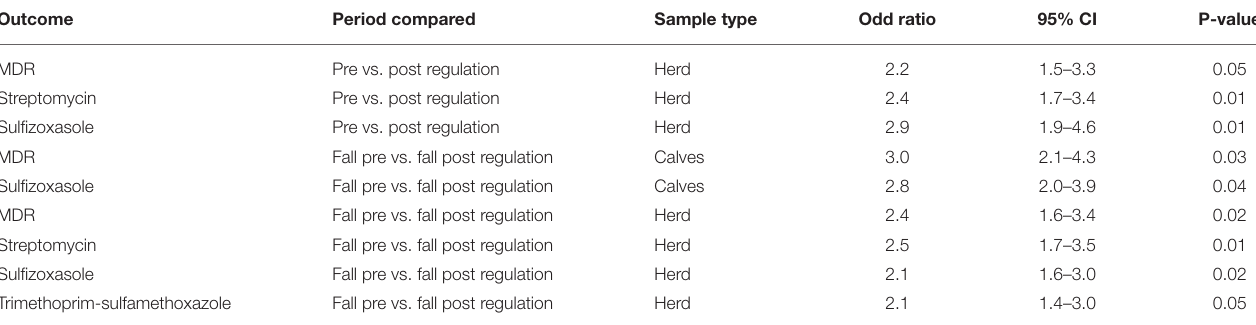
TABLE 3 | Parameter estimates and odds ratio from logistic regression models, for various outcomes, and using either the sample (feces from calves, feces from cows, manure pit sample) or herd as unit of analysis, based on the results of a cross-sectional study performed on 87 farms sampled in Québec, Canada between 2017 and